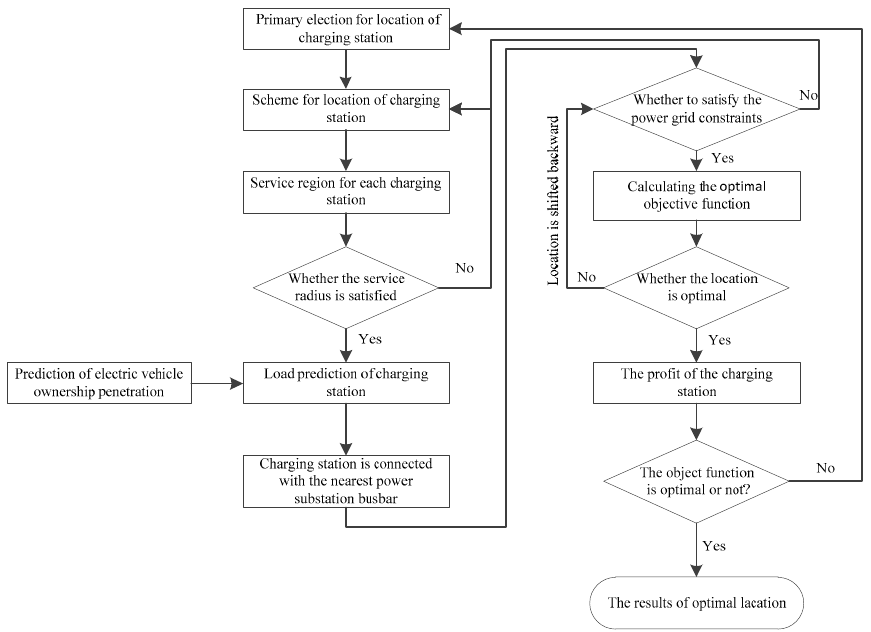
Figure 2. Flow chart detailing the programming of the charging station.